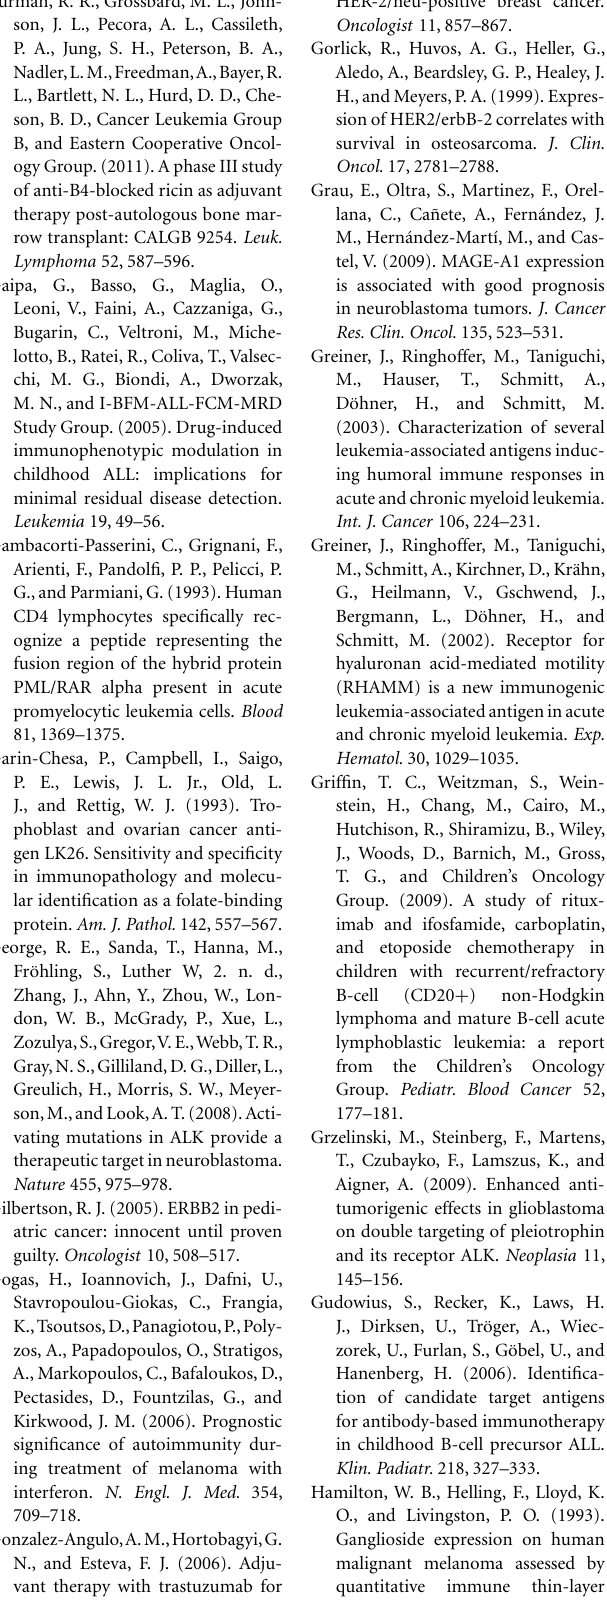
Figdor, C. G.,Adema, G. J., Hooger- brugge, P. M., Coulie, P. G., and de Vries, I. J. (2007). Cancer-germline gene expression in pediatric solid tumors using quantitative real-time PCR. Int. J. Cancer